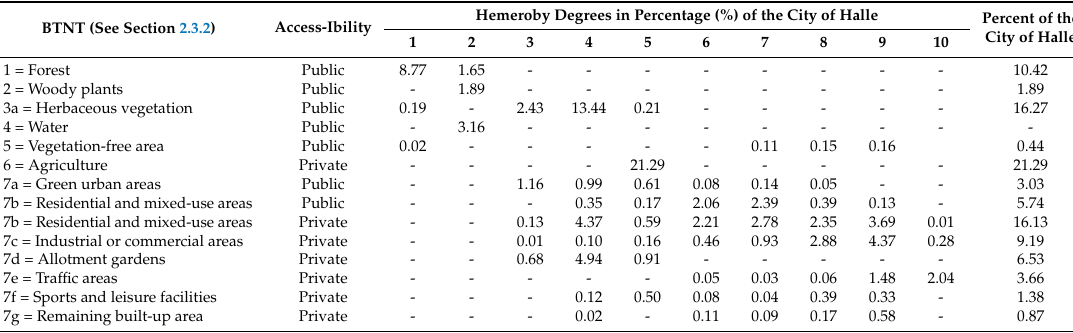
Table 10. Hemeroby of the regional biotope and land use data types (BTNT) in percentage of the total area of Halle. BTNT (See Section 2.3.2)